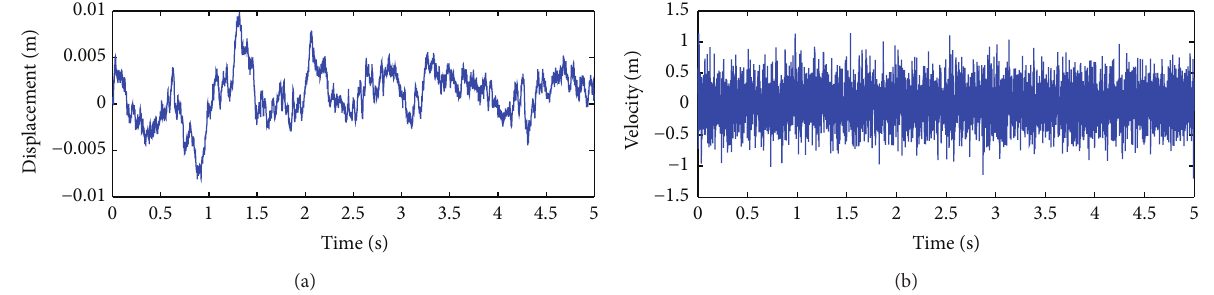
Figure 5: (a) Road profile for poor road. (b) Rate of road profile for poor road.